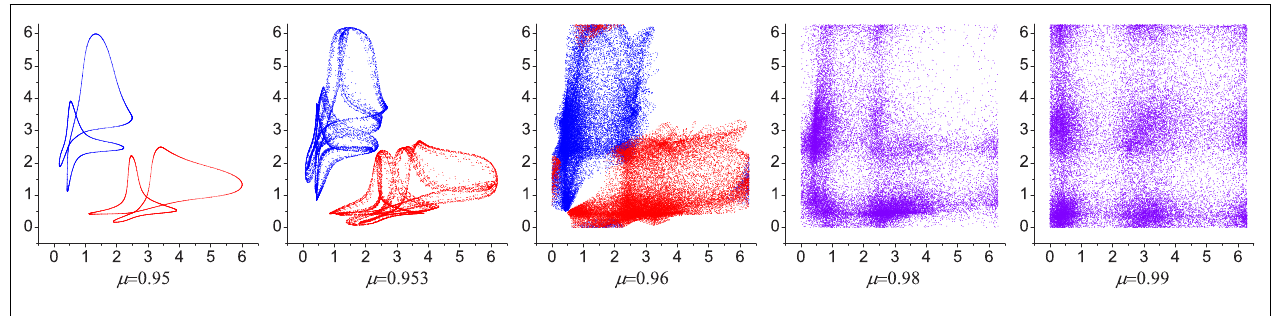
landscape in Figure 5 (red region near B and C). Near the maximum value of µ the attractors start to lose their stability and are eventually merged into a chaotic dynamics.The two coexisting weakly chaotic attractors can be seen in some narrow region near µ = 0.96, which is reminiscent of the crisis-type route to chaos.